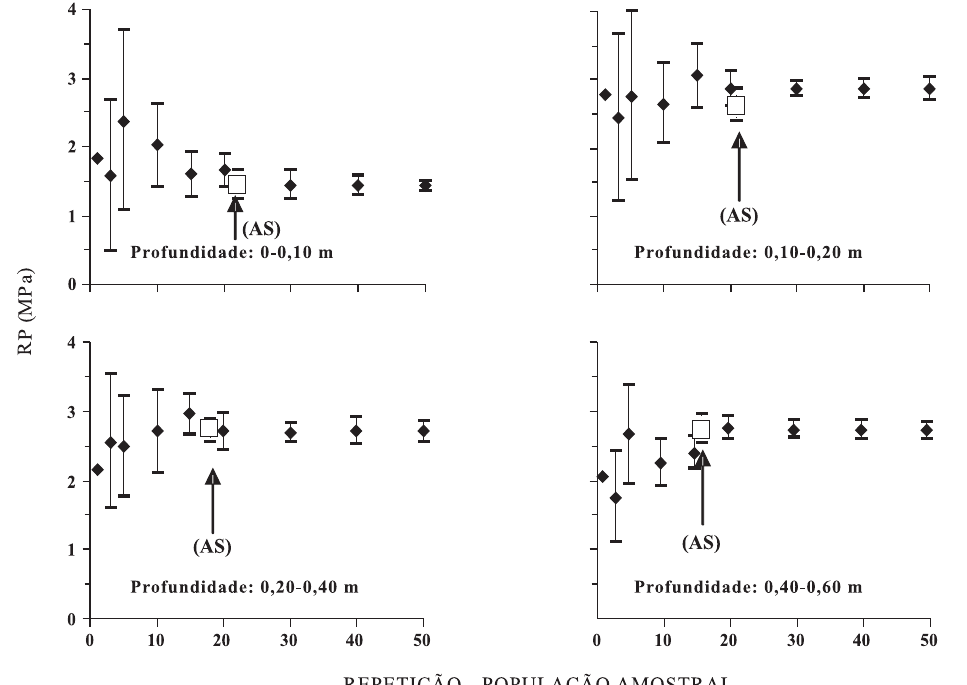
Figura 3. Valores médios e intervalo de confiança (95 %) da resistência do solo à penetração (RP) função da amostragem ao acaso (clássica) e da amostragem sistemática (AS), com penetrômetro de impacto em diferentes profundidades de um Latossolo Vermelho eutroférrico sob preparo